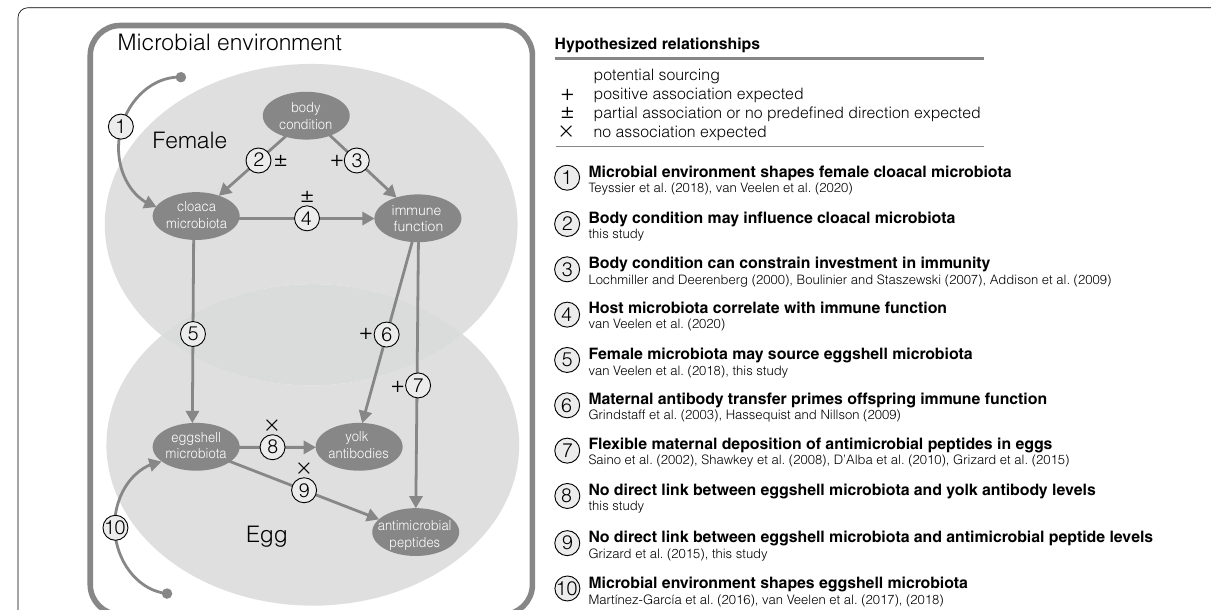
Fig. 1 Conceptual model describing potential microbial environment effects on maternal immunological priming of avian eggs [9, 13–15,